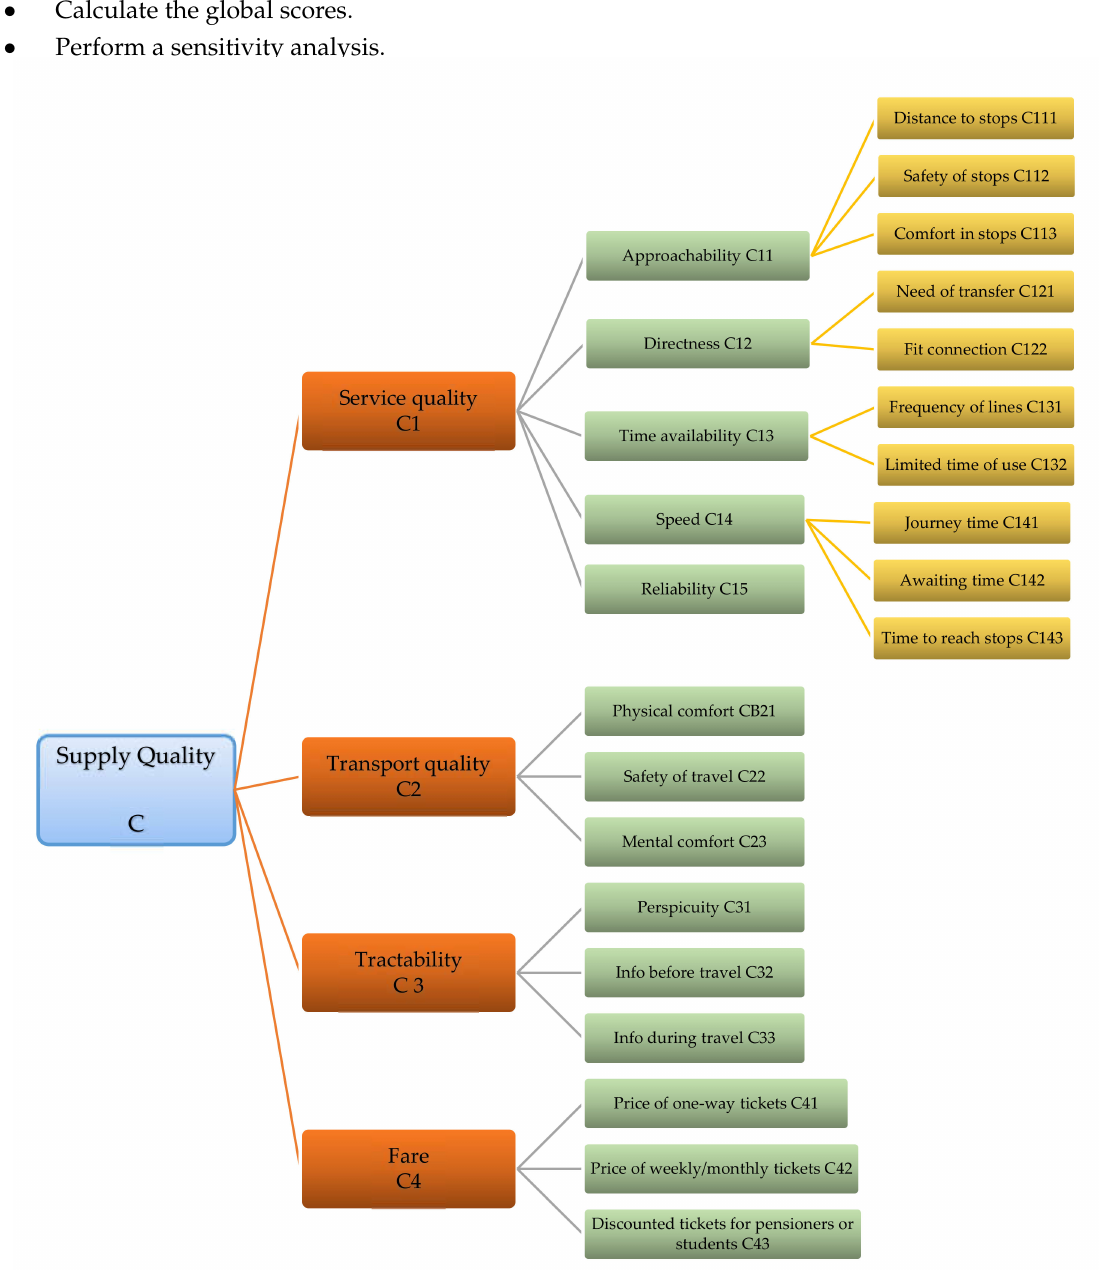
Figure 1. The hierarchical model of the public bus transportation supply quality criteria